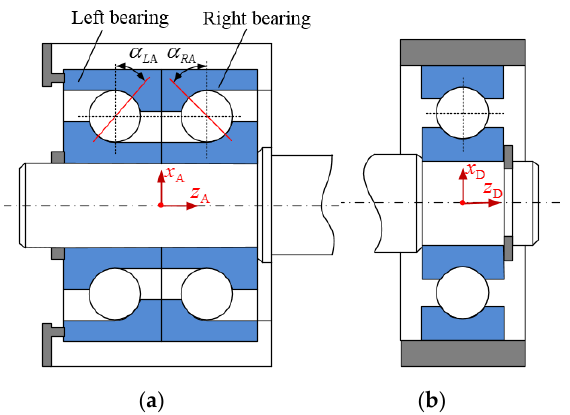
Figure 4. Assembly model between bearings and screw shaft: ( a ) Angular contact ball bearing; ( b ) Deep groove ball bearing.